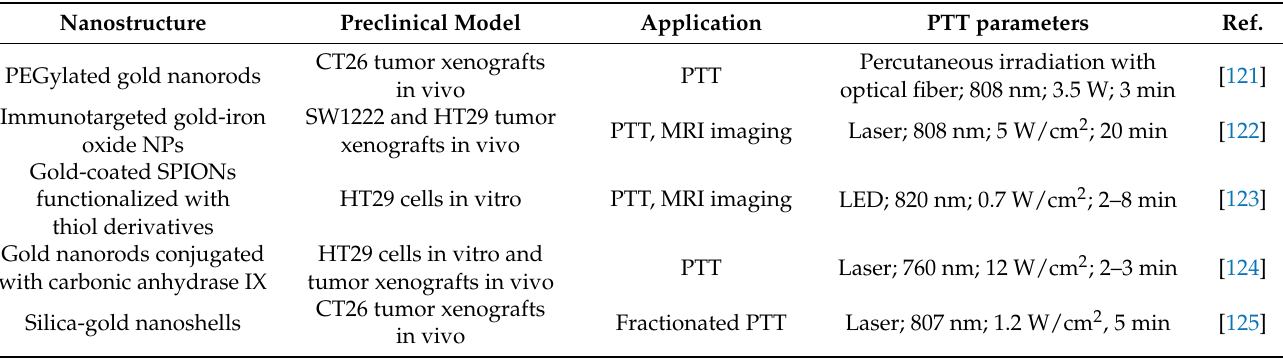
Table 1. Summary of highlighted preclinical studies evaluating photothermal therapy mediated by gold nanostructures in colorectal